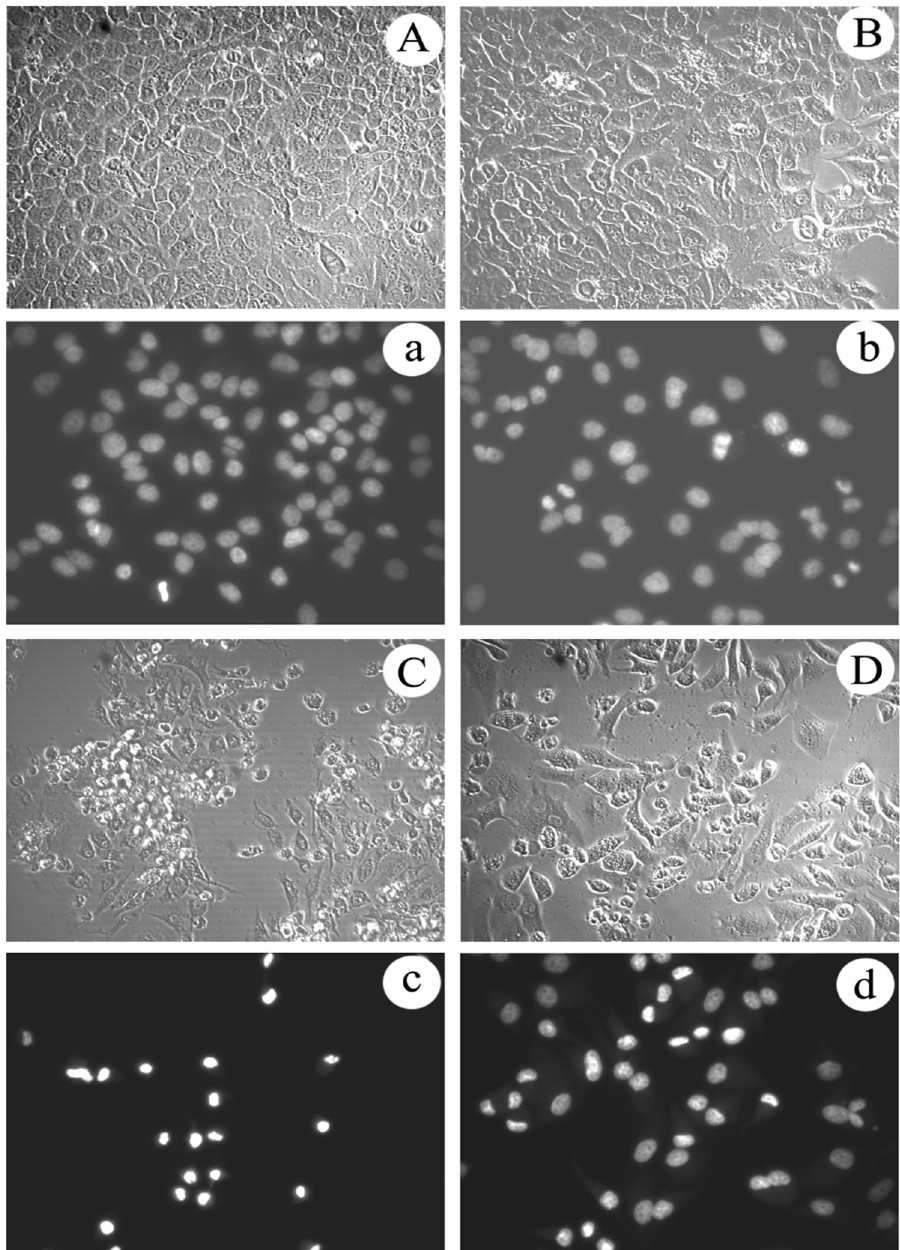
Figure 9. Analysis of proliferation and cell morphological change in Hela229 cells treated with matrine derivatives 1 and 2 for 48 h. Photographs marked with capital letters were obtained from IPCM (inverted phase contrast microscopy), with small letters from FM (fluorescence microscopy); magnification was 200X . ( A ) Morphological characteristics of cell in control; (a) Morphological characteristics of cell nucleus in control; ( B ) Morphological changes of cell induced by matrine; (b) Nucleus morphological changes of cell induced by matrine; ( C ) Morphological changes of cell induced by matrine derivative 1; (c) Nucleus morphological changes of cell induced by matrine derivative 1; ( D ) Morphological changes of cell induced by matrine derivative 2; (d) Nucleus morphological changes of cell induced by matrine derivative